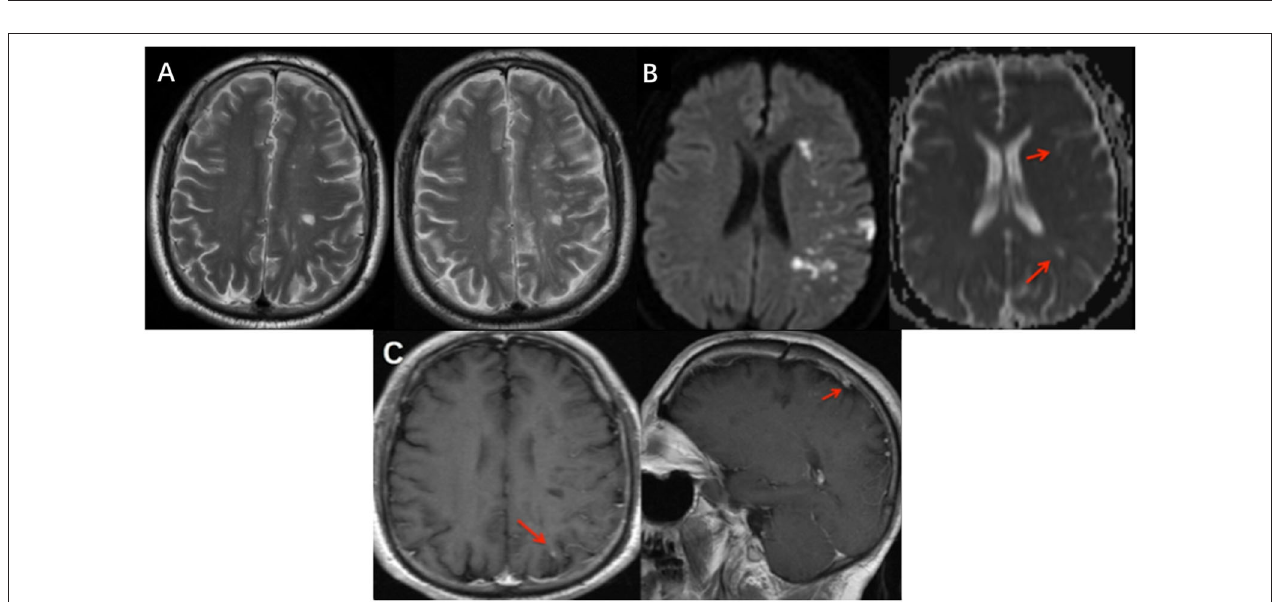
cerebral watershed infarction due to MM, which was proved by MRI and DSA. Therefore, we diagnosed this patient with MM and MS